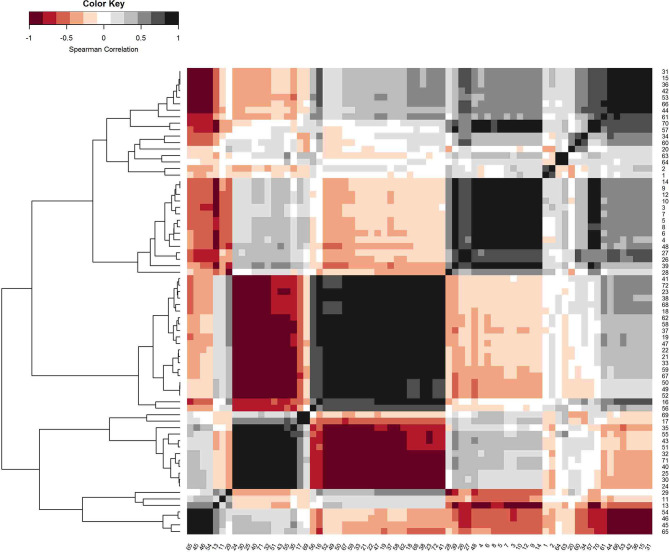
Correlation matrix (Spearman correlation) of the derived radiomics features. Features were ordered with a hierarchical agglomerative clustering algorithm to visualize clusters of collinearity to allow for variable selection.